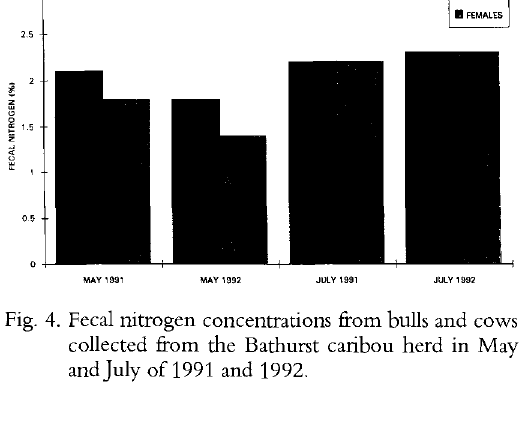
Fig. 4. Fecal nitrogen concentrations from bulls and cows collected from the Bathurst caribou herd in May and July of 1991 and